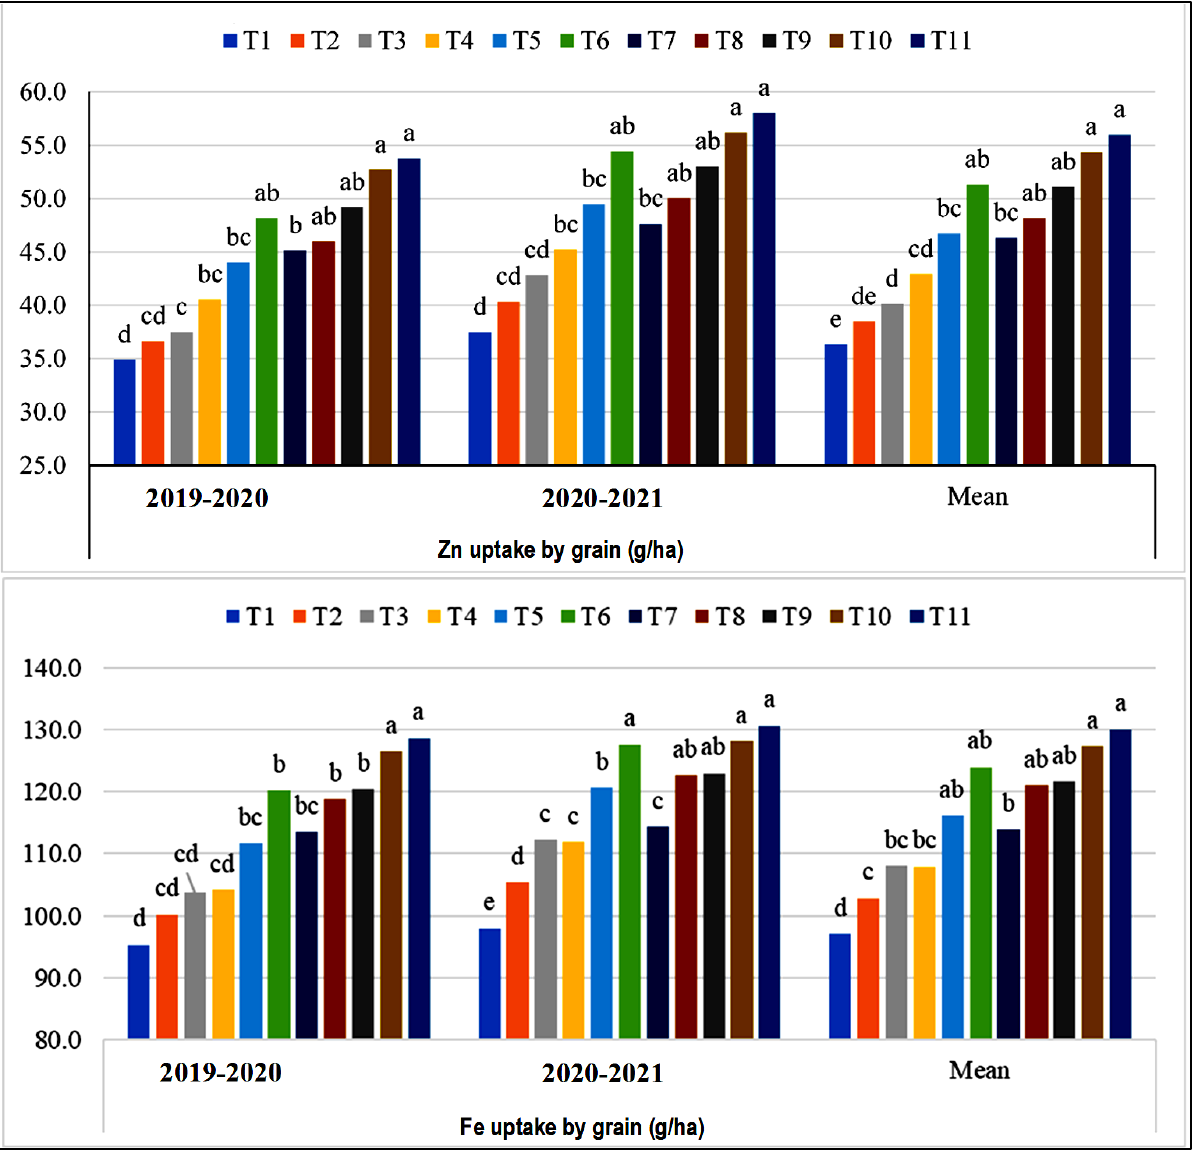
Figure 5. Influence of urea and micronutrient foliar spray on Zn uptake and Fe uptake by grains of Indian mustard. Treatments details are available in Table 1. The bar with a similar or dissimilar letter(s) was evaluated with the least significant difference (LSD) multiple range tests using a probability level of p ≤ 0.05.